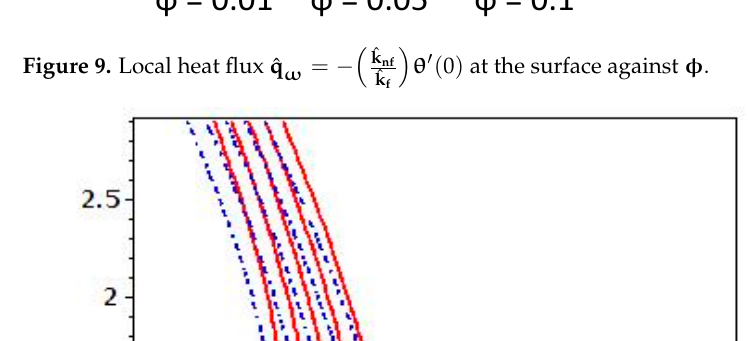
Figure 9. Local heat flux ˆ q ω = −